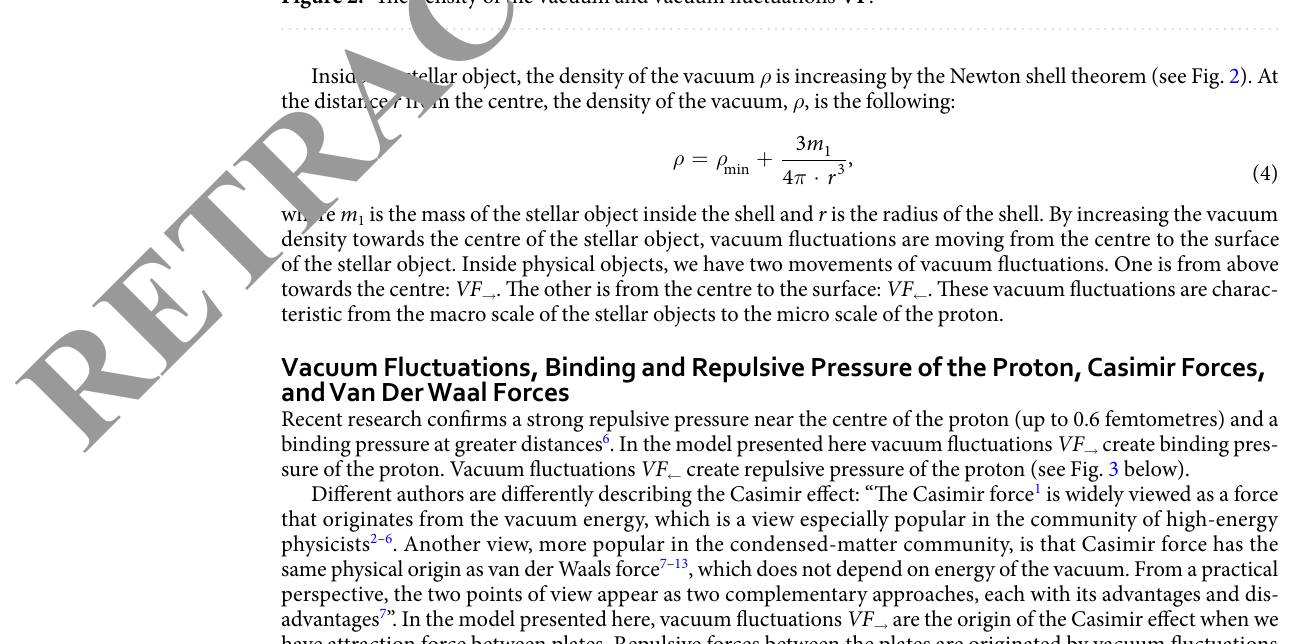
Figure 2. The density of the vacuum and vacuum fluctuations VF